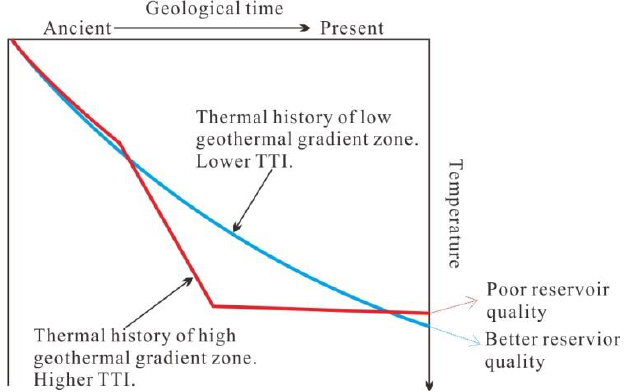
Figure 11. Schematic diagram of the relationship between thermal history and reservoir quality.